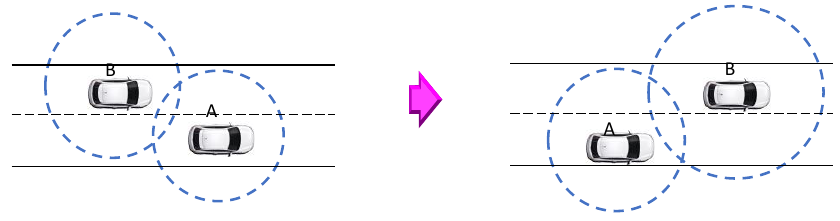
Figure 6. Conceptual illustration of the topological vehicle sequence shown in Figure 5.